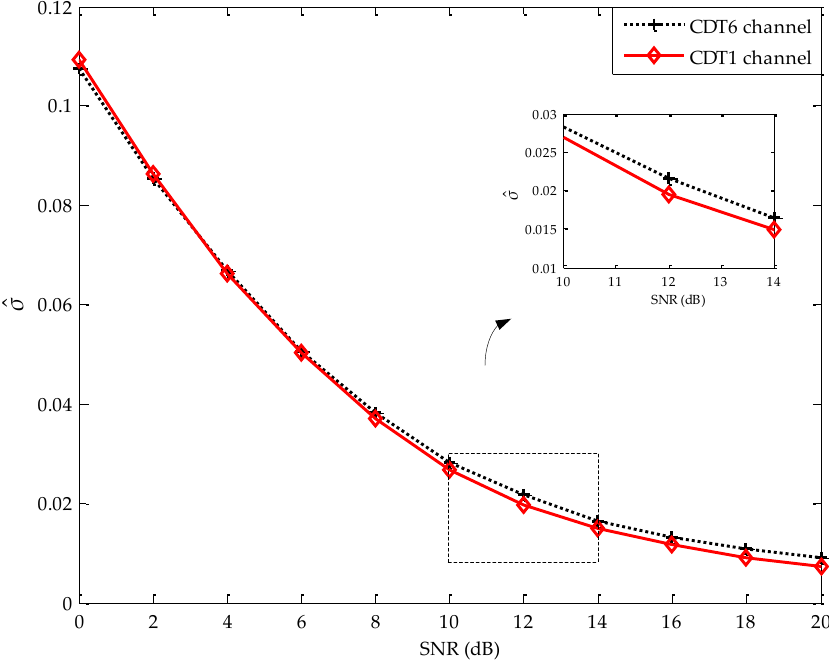
Figure 5. The threshold ˆ σ under CDT1 and CDT6 channels.